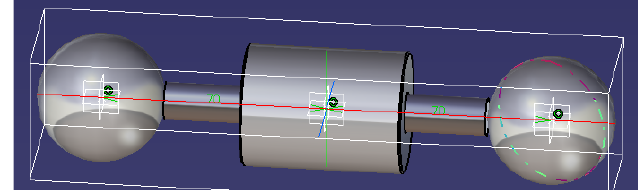
Figure 10. CAD model of the rotor.